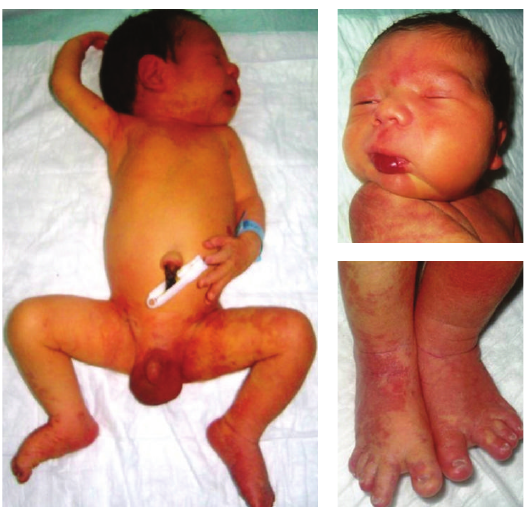
Figure 1: Common port wine stain partially involving the skin overlying the right arm, sternal region in the neck, right temporooc- cipital region, right leg, anterior and posterior parts of left leg, an hemangioma with a size of 2 × 1 cm in his lower lip, hypertrophy on left cheek, widened first interdigital space, dystrophia in the nail of the first digit of the right foot, and bilateral hypertrophy of the first digits of the